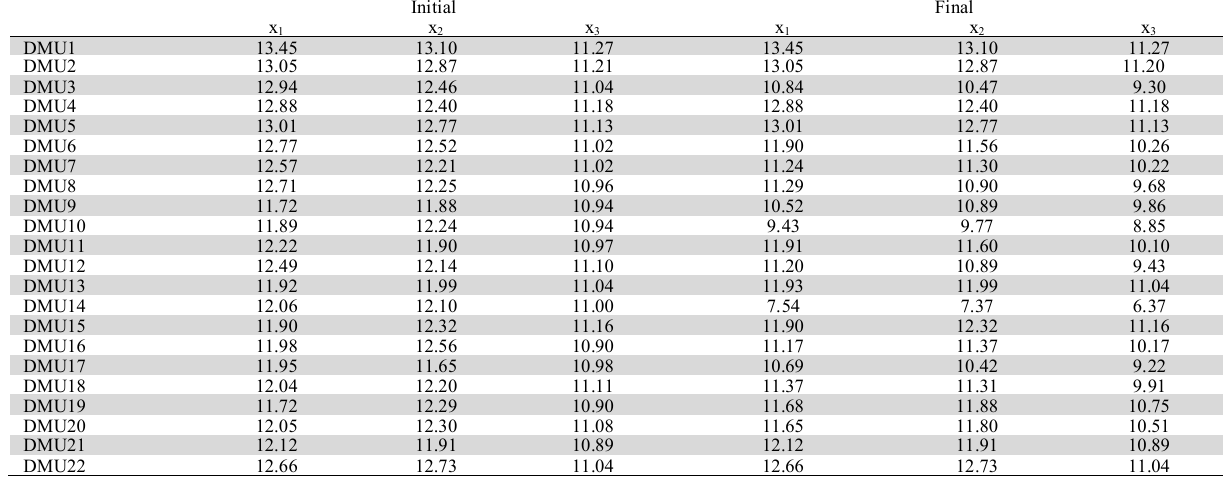
The summary of efficient weights of input projection